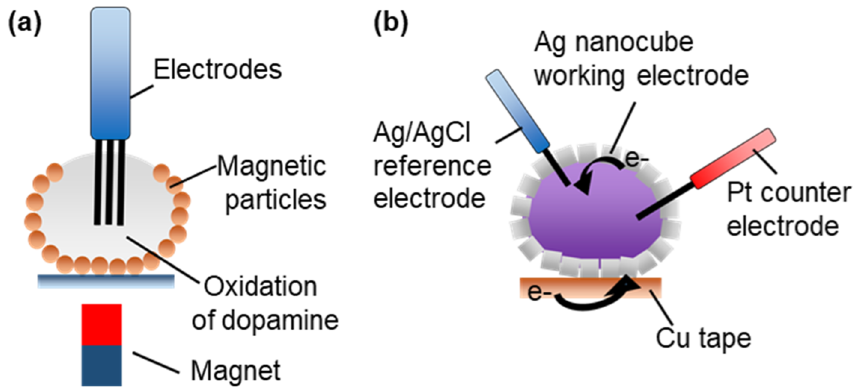
Figure 7. Electrochemical microreactor based on a liquid marble platform. ( a ) Liquid marble opened by magnetic force for the electrochemical detection of the oxidation of dopamine [41]. ( b ) The shell of plasmonic liquid marbles was used as a working electrode for the redox reaction of Ru 3 + and electroreduction of methylene blue [74].